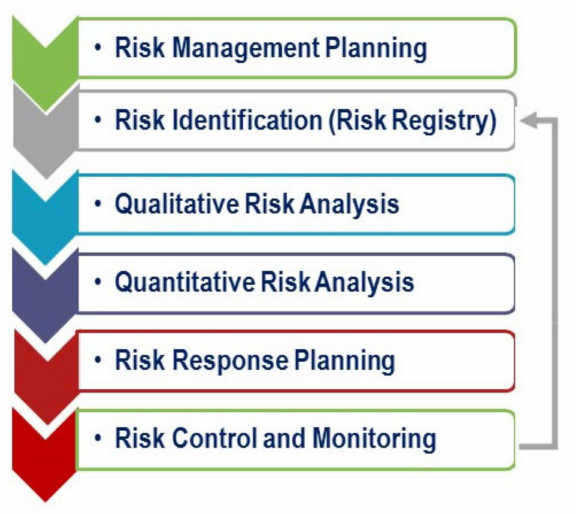
Figure 1. Risk assessment and management workflow diagram depicting six primary tasks and how they